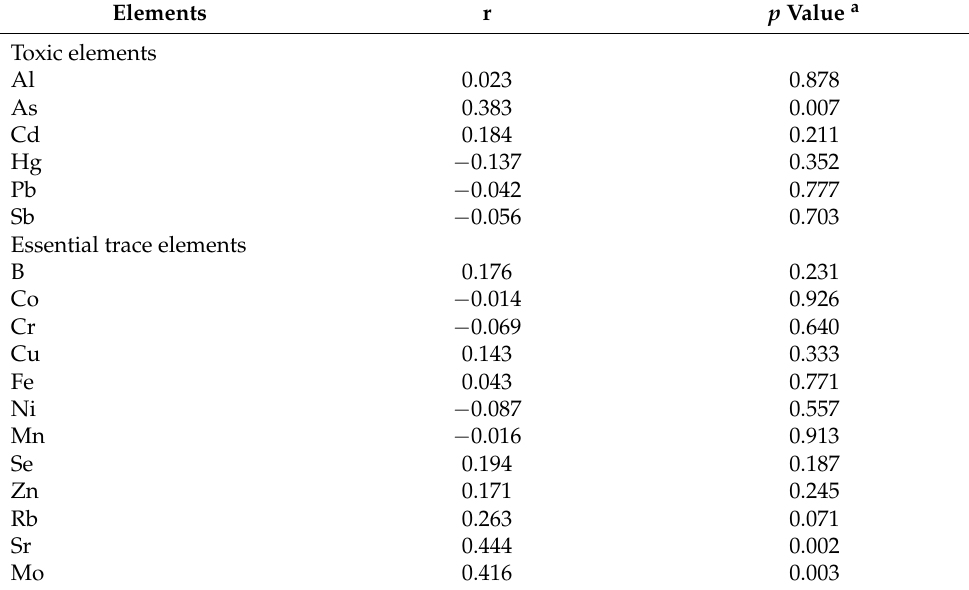
Table 4. Spearman correlation analysis of trace elements in maternal blood (MB) at 3rd trimester and in cord blood (CB). Elements r p Value